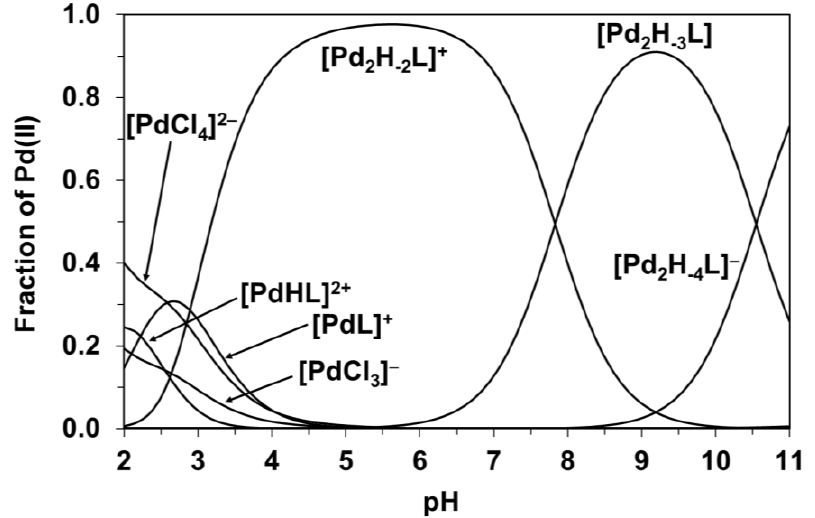
Figure 2. Calculated concentration distribution curves for the Pd(II) − (L1) − system at a 2:1 ratio, c L = 5 mM. “L” refer s to the L1 ligand in the formulae of the various